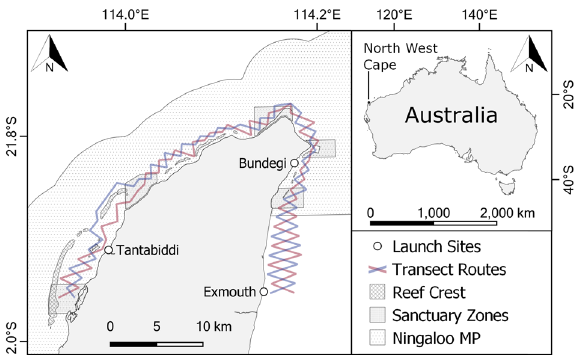
Figure 1. The North West Cape, Western Australia, showing vessel launch sites and two opposing, zigzag transect routes (Route A: blue; Route B: red) used to survey for Australian humpback ( Sousa sahulensis ) and Indo-Pacific bottlenose dolphins ( Tursiops aduncus ).